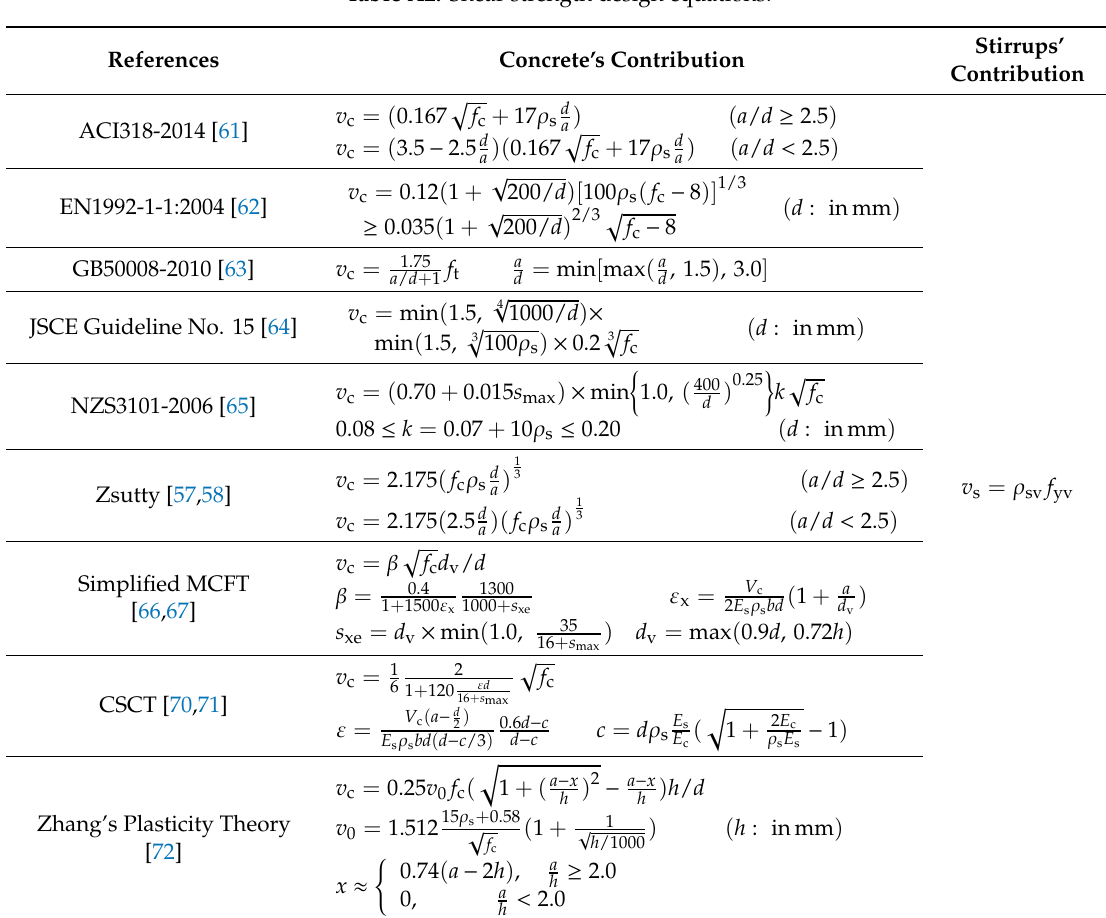
Table A2. Shear strength design